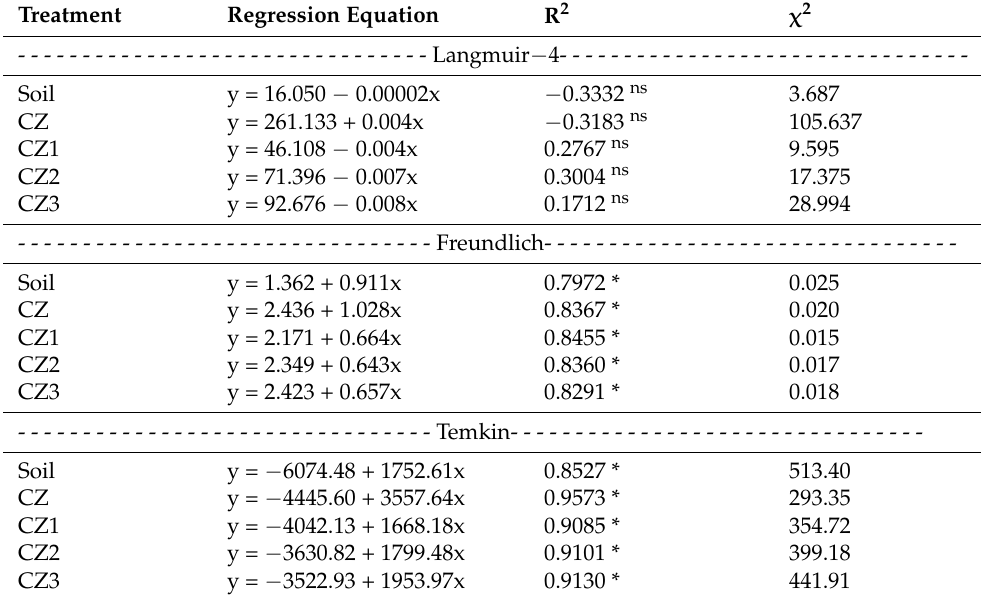
Table 19. Fitting Langmuir type 4, Freundlich, and Temkin isotherms to the potassium adsorption data based on simple regression and Chi-square analyses